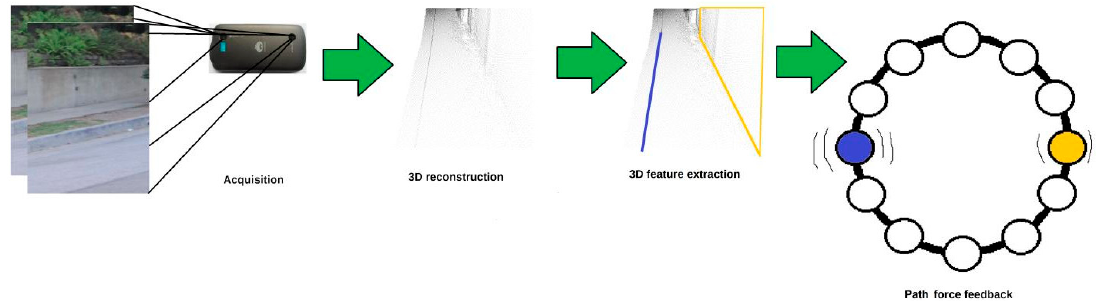
Figure 24. The detection process of force feedback belt [46].